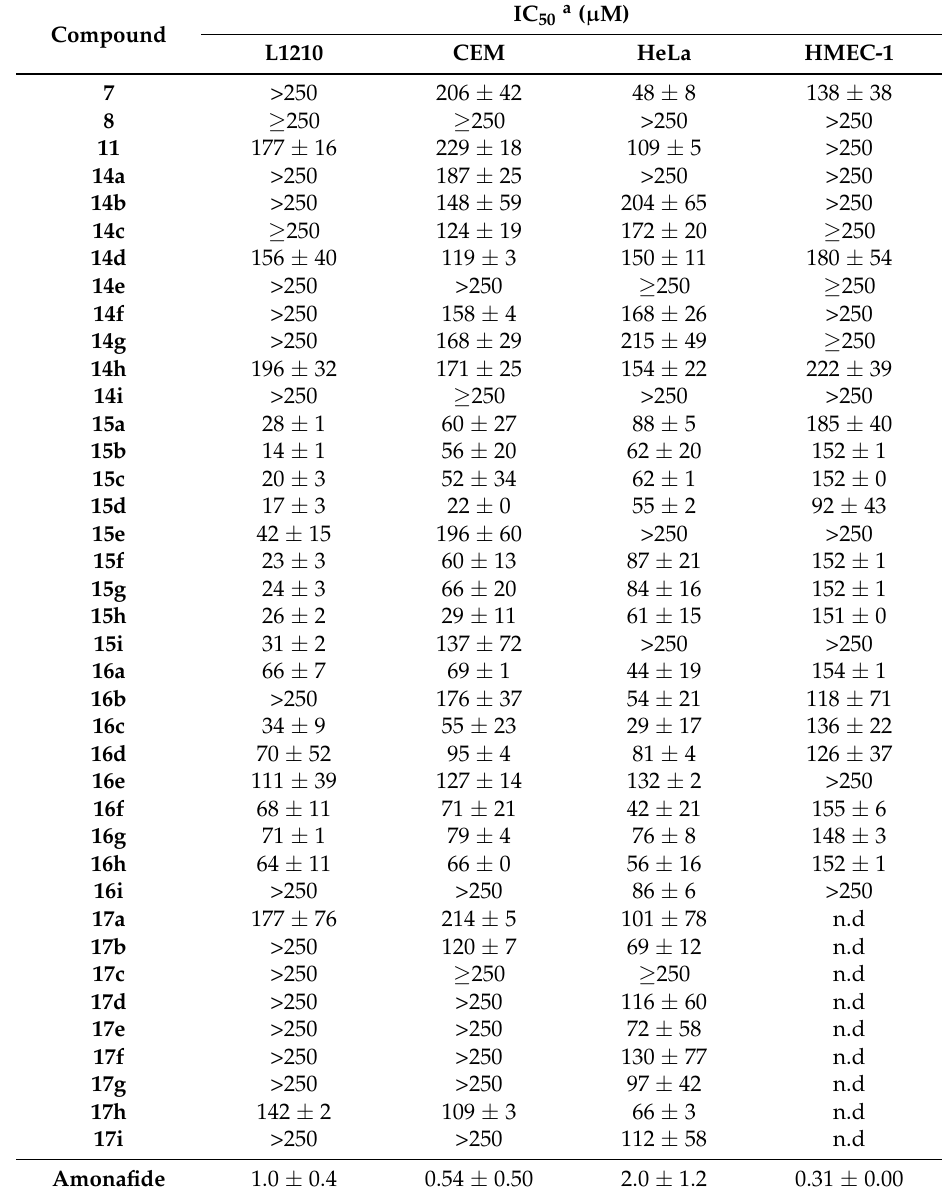
Table 2. The inhibitory effect of the tested compounds against the proliferation of murine leukemia (L1210), human T-lymphocyte (CEM) and human cervix carcinoma cells